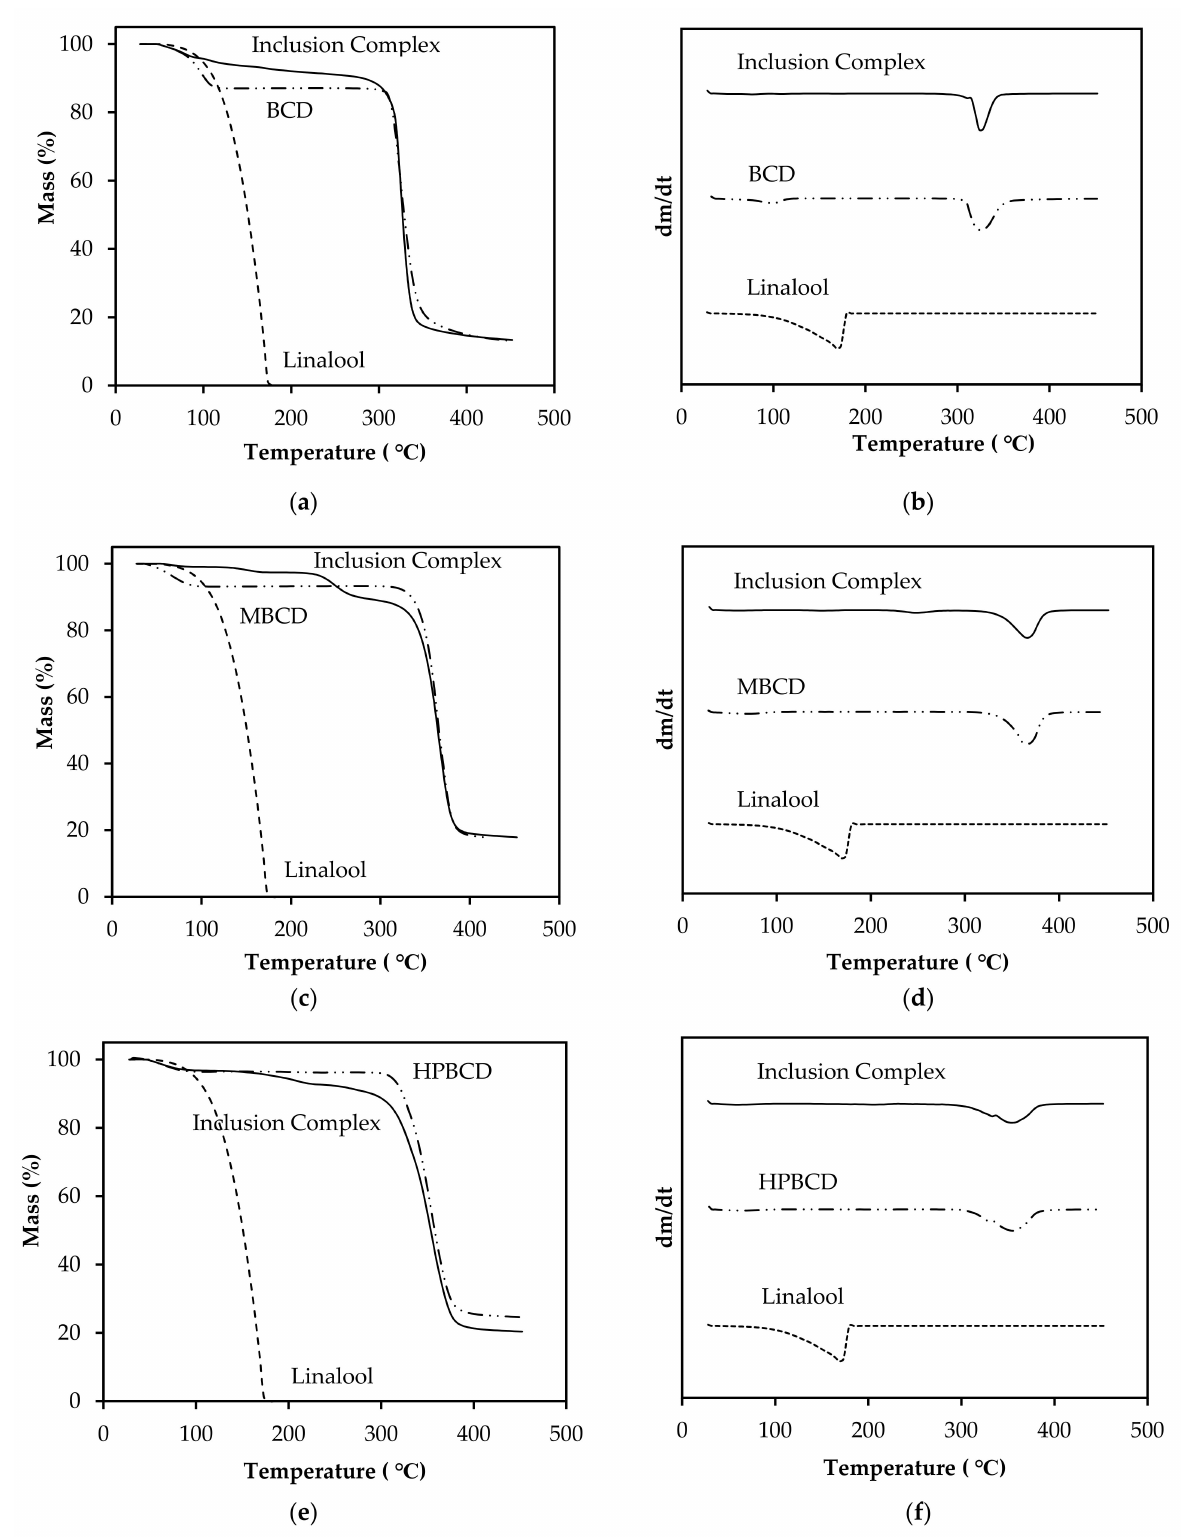
Figure 15. TG and DTG curves of ( a , b ) linalool/BCD inclusion complex, BCD, and linalool; ( c , d ) linalool/MBCD inclusion complex, MBCD, and linalool; ( e , f ) linalool/HPBCD inclusion complex, HPBCD, and